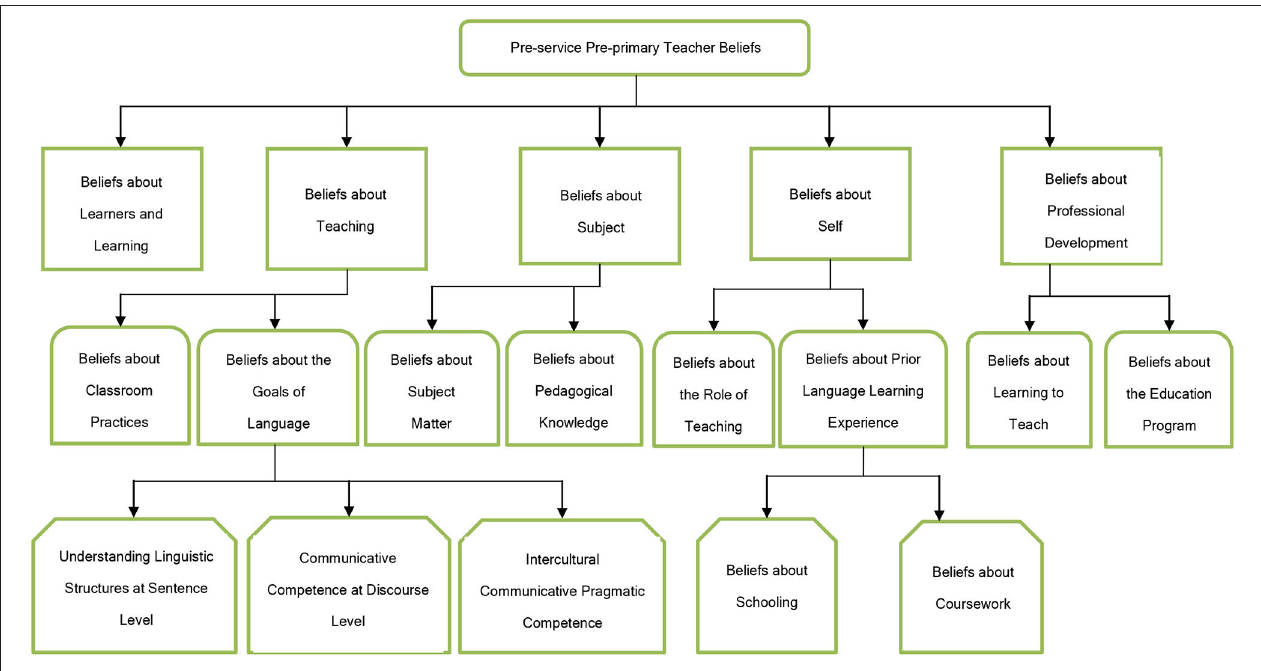
FIGURE 1 | The concept-driven coding